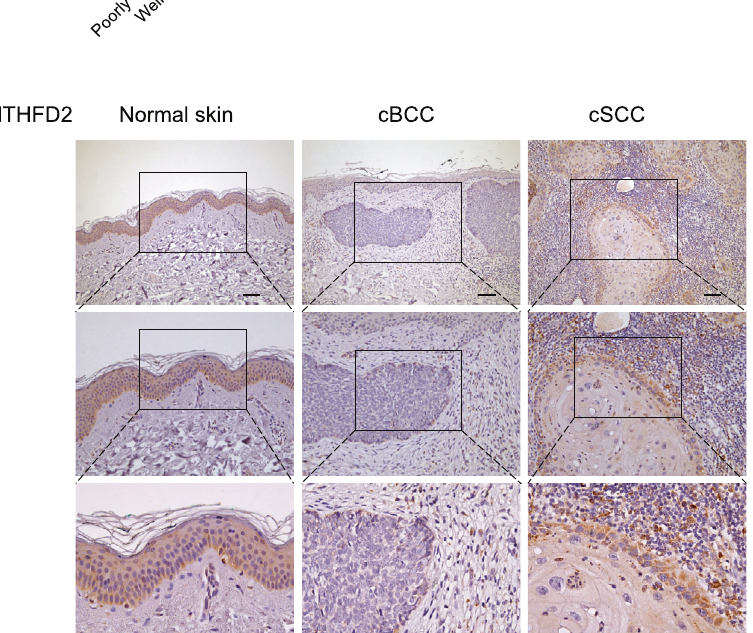
Fig. 2 SHMT2 and MTHFD2 are differentially expressed in normal skin and Non-Melanoma skin cancer. A Immunohistochemical staining for SHMT2 performed on Tissue Micro Array (TMA), containing cases of normal skin ( n = 10), cutaneuos Basal Cell Carcinoma ( n = 14) and cutaneous Squamous Cell carcinoma ( n = 43). B SHMT2 expression in 3 representative samples of normal skin, cBCC and cSCC. C Histological index of SHMT2 expression in normal skin (divided into Dermis, Basal Stratum-BS-, Granulosum Stratum-GS-, Spinous Stratum-SS-, and Corneum Stratum), cBCC and cSCC (divided into Well differentiated cSCC and Poorly differentiated cSCC). D Immunohistochemical staining for MTHFD2 performed on FFPE tissues of normal skin, cutaneuos Basal Cell Carcinoma (cBCC) and cutaneous Squamous Cell carcinoma (cSCC). Scale Bar = 100 μ m. The p -value was obtained using Student ’ s t test. Values were considered signi fi cant when the p -value < 0.05, n.s. not signi fi cant.